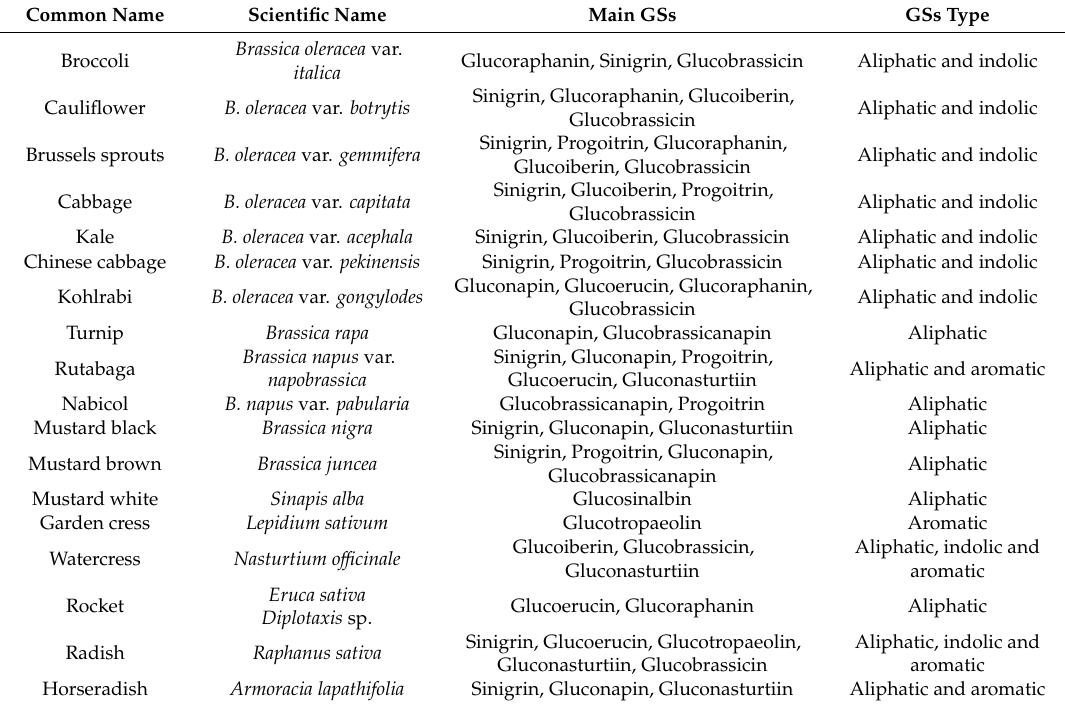
Table 1. Glucosinolates (GSs) in vegetable and salad crops of Brassicaceae